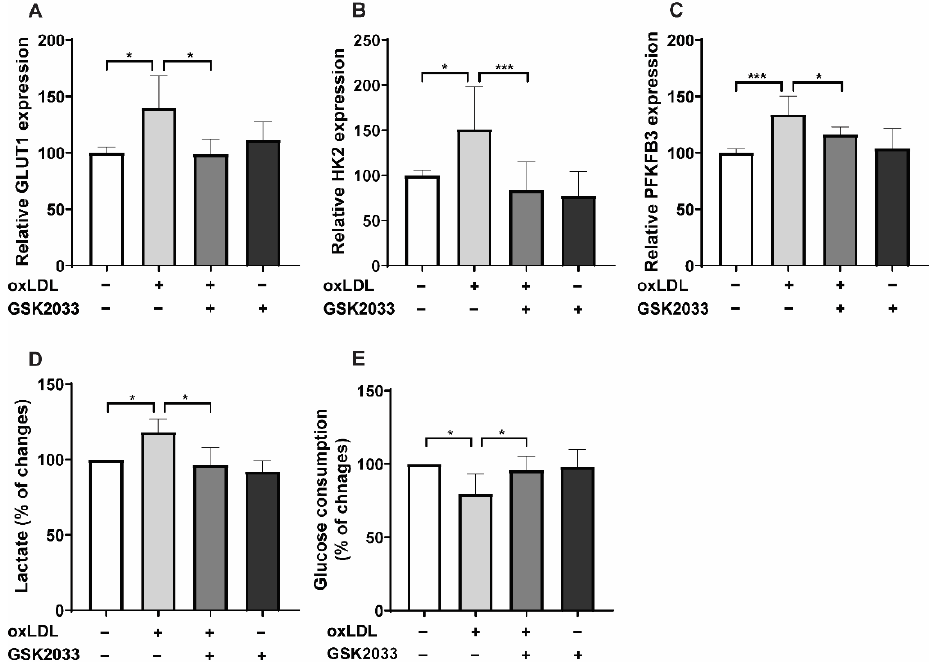
Figure 2. LXR inhibition alters oxLDL-induced metabolic reprogramming. Monocytes were treated as indicated with 20 µg/mL oxLDL, 2.5 µM GSK2033 (LXR antagonist), or vehicle for 24 h and either lysed for RNA expression or kept for 5 days in complete medium for lactate assays and glucose consumption. mRNA levels of GLUT1 , HK2, and PFKFB3 were analyzed by real-time qPCR ( A – C ). On day 6 lactate concentration was measured in the cell lysate and glucose concentration was measured in the supernatant ( D , E ). Graphs represent mean values ± SD of six individuals in three different experiments. * p < 0.05 and *** p < 0.001.